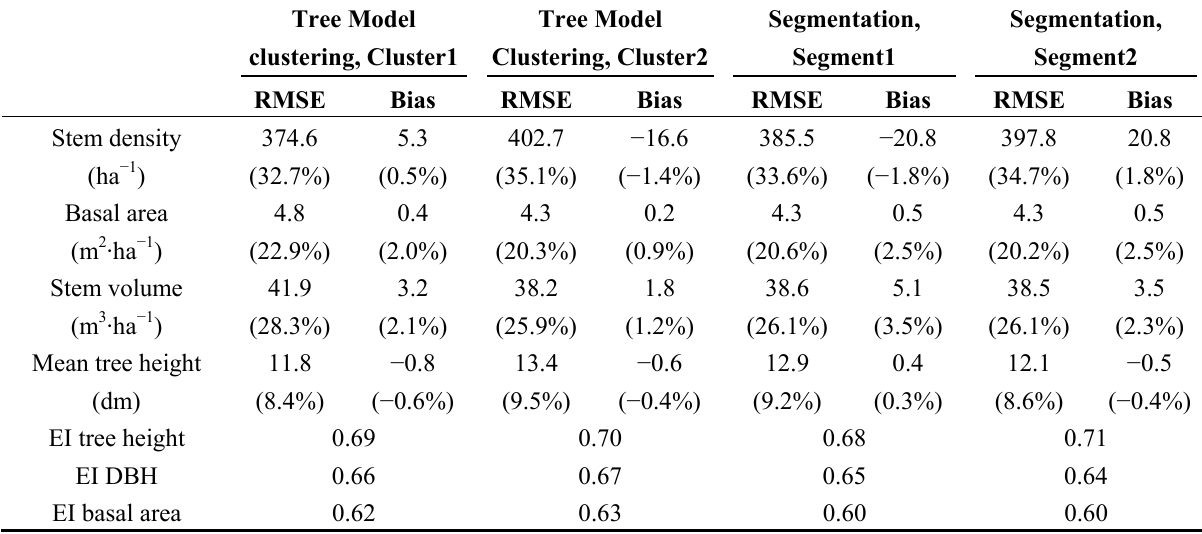
Table 6. RMSE and bias of estimates at plot level and EI for the different